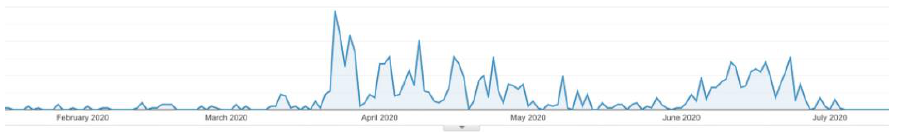
Fig. 7c. Dynamics of visits to the Change of variable (substitution) in a definite integral.